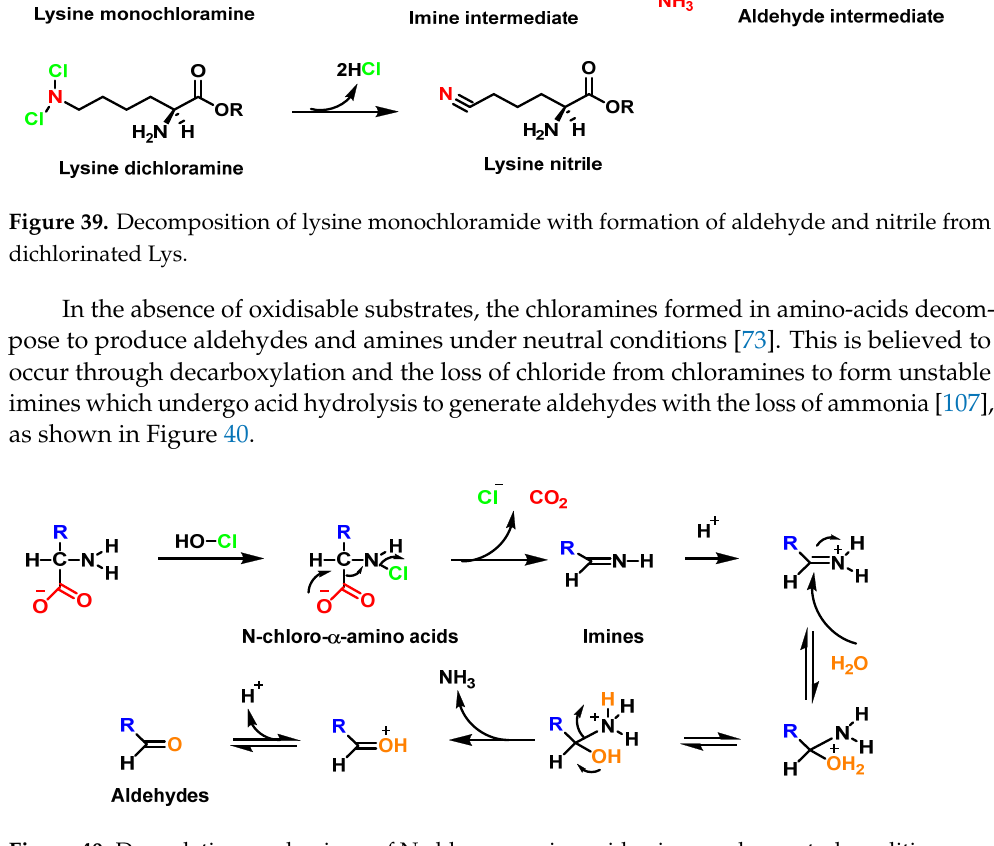
Figure 41. ( a ) β -fragmentation reaction by homolytic cleavage of the C-C bond in position to an N- centred radical, giving rise to an iminic derivative and a C-radical R; and ( b ) β -fragmentation by homolytic cleavage with the loss of CO 2 and a C-centred radical. Another reaction is that of the intra- or intermolecular hydrogen abstraction, a 1,2, 1,5 (and sometimes 1,6) transfer of a hydrogen atom from a delta or epsilon carbon to the